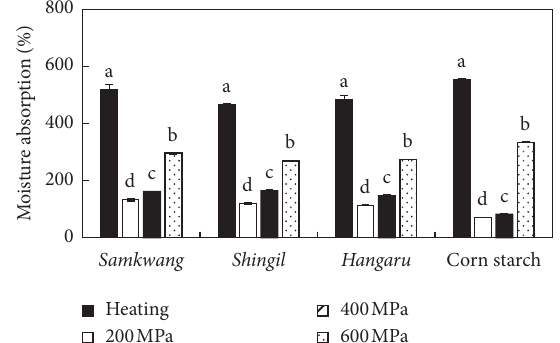
Figure 2: Moisture absorption of different rice flours by treatment methods. Values are mean ± SD. n � 3. Different small letters in the same items indicate a significant difference by Duncan’s range test ( p < 0 . 05) according to the treated